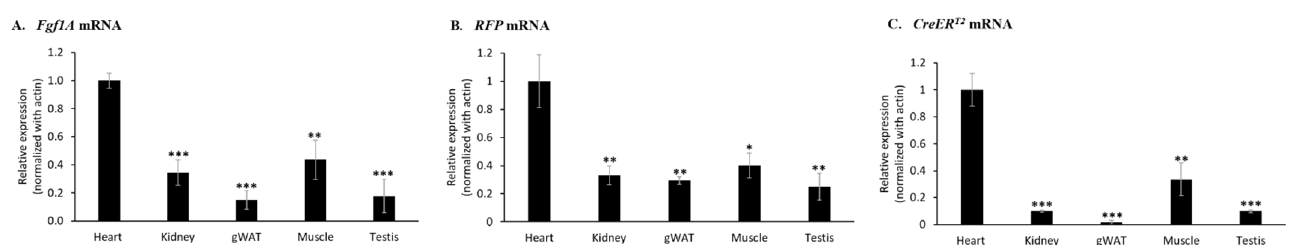
Figure 2. Endogenous Fgf1A RFP and CreER T2 mRNA expression of F1A-CreER T2 transgenic mice. Total RNA from tissues of F1A-CreER T2 (#13A) adult male transgenic mice were extracted. ( A ) The levels of Fgf1A mRNA were higher in heart, kidney and muscle than in other tissues. Similar expression mRNA patterns could be observed in the ( B ) RFP and ( C ) CreER T2 gene, which is driven by the mouse Fgf1A promoter. The mRNA expression levels of Fgf1A, CreER T2 and RFP were analyzed by quantitative PCR, normalized to β -actin, and compared with the heart tissue. These results are shown as means ± SD, n = 3, * p < 0.05, ** p < 0.01 and *** p < 0.001.